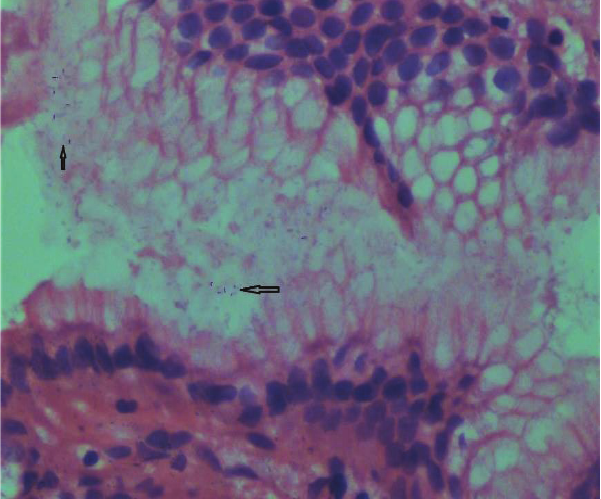
Fig-2: H&E shows H.pylori in gastric pits